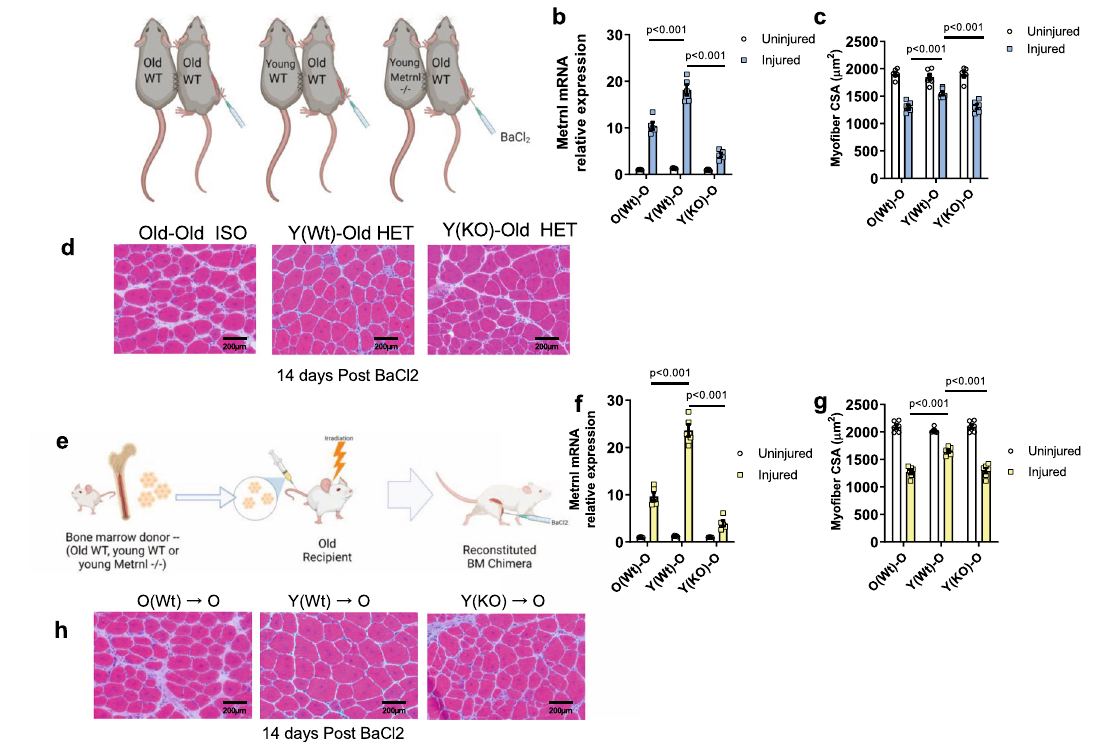
Fig. 2 | Replacement ofcirculating Metrnl improves aged muscle regeneration followingBaCl 2 injection.a GraphicalrepresentationofHeterochronicparabiosis groups ( n =6/old WT parabionts tested per group). b Metrnl mRNA content mea- suredbyqPCRfromuninjuredand24-hourspost-injuryTAmusclesofoldwild-type parabiont ( n =5 animals/group); 2×3 ANOVA was used with Fisher ’ s LSD post hoc analysis only to compare differences between injured groups. c Cross-sectional area quanti fi ed from micrographs ( n =6 animals/group); 2×3 ANOVA was used with Fisher ’ s LSD post hoc analysis only to compare differences between injured groups. d Representative Hematoxylin and Eosin-stained micrographs from c — 14 days following BaCl2-induced muscle damage in the old wild-type parabionts. e Graphical representation of Bone marrow chimera experiment. f Metrnl mRNA